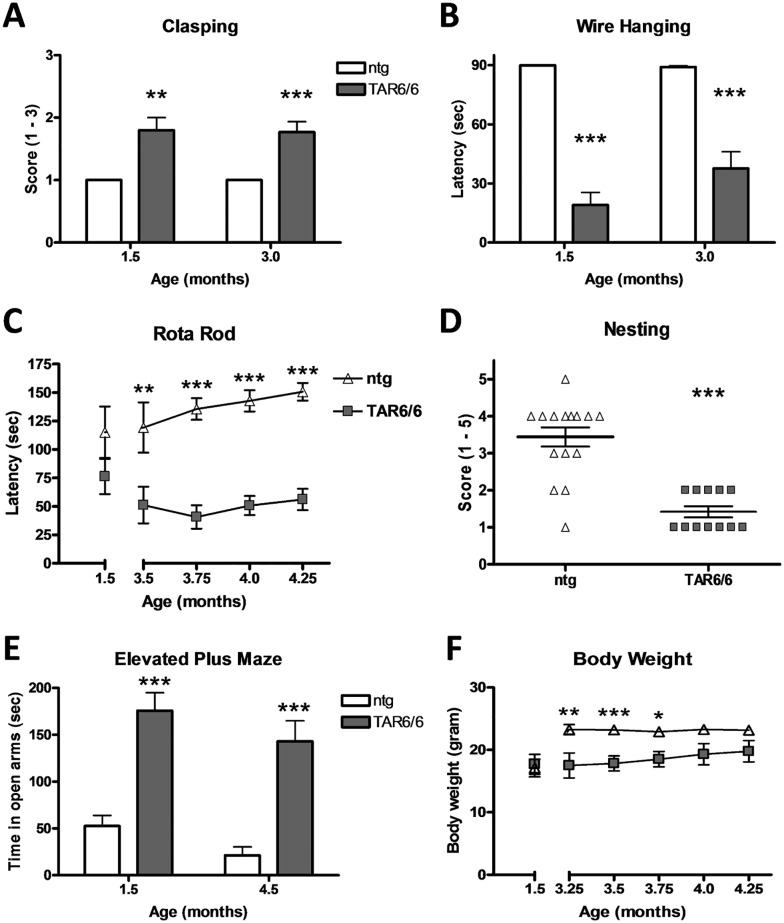
Motor impairments and reduced anxiety in TAR6/6 mice.(A) Clasping behavior scored from 1–3 of 1.5 and 3 months old TAR6/6 mice compared to ntg littermates (score of 1: normal clasping). (B) Latency to fall in the wire suspension test in seconds of 1.5 and 3 months old TAR6/6 mice compared to ntg littermates. (C) Latency to fall from the rotating rod in the Rota Rod test of 1.5 to 4.25 months old TAR6/6 mice compared to ntg littermates. (D) Nesting behavior scored from 1–5 of 3 months old TAR6/6 mice compared to ntg littermates (high score: perfect nest). (E) Time in seconds of 1.5 and 4.5 months old TAR6/6 mice spent in the open arms of the elevated plus maze compared to ntg littermates. F: Body weight in gram of 1.5 to 4.25 months old TAR6/6 mice compared to ntg mice of the same age. (A, B) 1.5 months: TAR6/6: n = 5, ntg: n = 7; 3 months: TAR6/6: n = 13, ntg: n = 16. (C) 1.5 months: TAR6/6: n = 5, ntg: n = 7; 3.5 months: TAR6/6: n = 8, ntg: n = 7; 3.75 months: TAR6/6: n = 12, ntg: n = 16; 4 months: TAR6/6: n = 10, ntg: n = 16; 4.25 months: TAR6/6: n = 9, ntg: n = 16. (D) TAR6/6: n = 16, ntg: n = 12. E: 1.5 months: TAR6/6: n = 6, ntg: n = 4; 4.5 months: TAR6/6: n = 8, ntg: n = 16. (F) 1.5 months: TAR6/6: n = 5, ntg: n = 7; 3.25 months: TAR6/6: n = 7, ntg: n = 12; 3.5 months: TAR6/6: n = 12, ntg: n = 18; 3.75 months: TAR6/6: n = 10, ntg: n = 18; 4.0 months: TAR6/6: n = 8, ntg: n = 18; 4.25 months: TAR6/6: n = 8, ntg: n = 18. (A-C, E, F). Two-way ANOVA followed by Bonferroni‘s post-hoc test. D: Mann Whitney U-test. A,B,E: Mean+SEM; C,D,F: Mean±SEM. *p<0.05, **p<0.01, ***p<0.001.